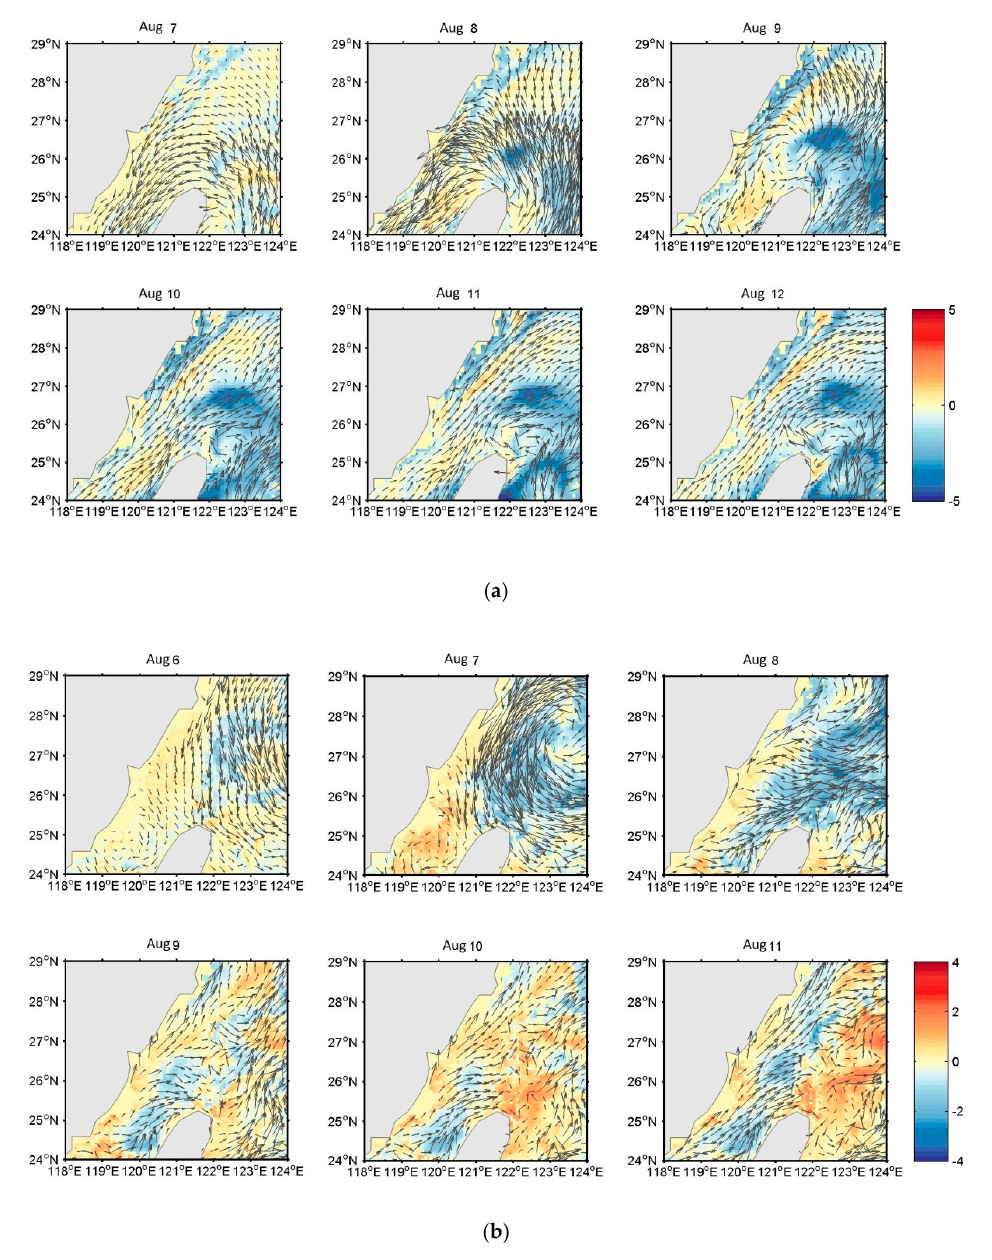
Figure 10. Daily surface temperature and velocity at surface ( a ) deviating from the day before the Typhoon Morakot (06/08/2009) and ( b ) deviating from the day before the Typhoon Haikui (05/08/2012). Daily mean model data were provided by the HYCOM GLBa0.08 experiment. The vectors are represented by the difference of current in zonal and meridional components.